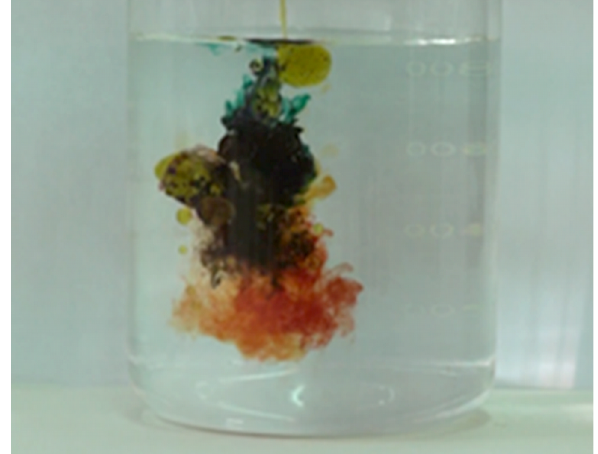
Figure 6. Round coloured spheres sink and pierce the oil